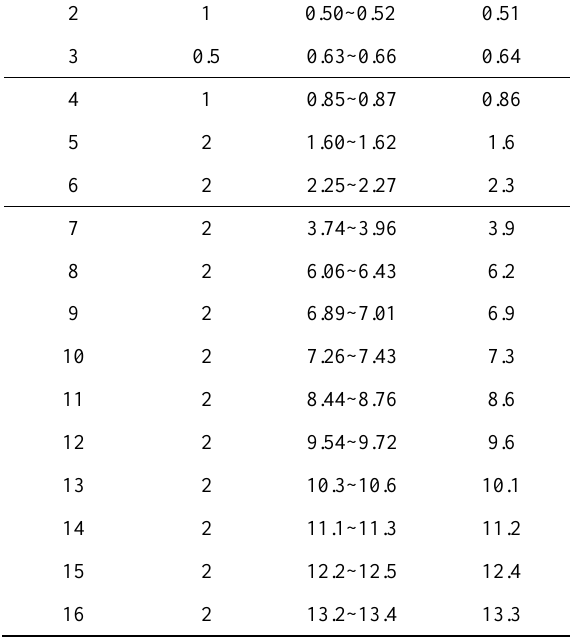
Table 1. Band information of Himawari-8